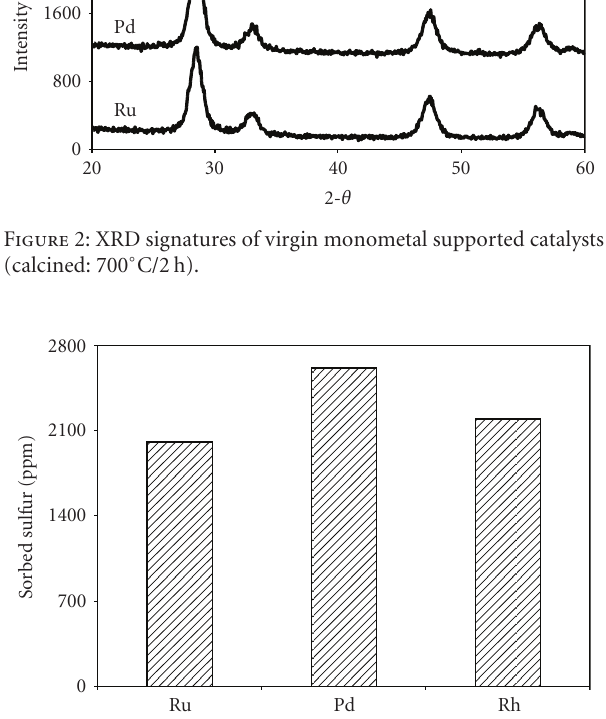
Figure 3: Quantification of sulfur pick-up by the formulations developed in this